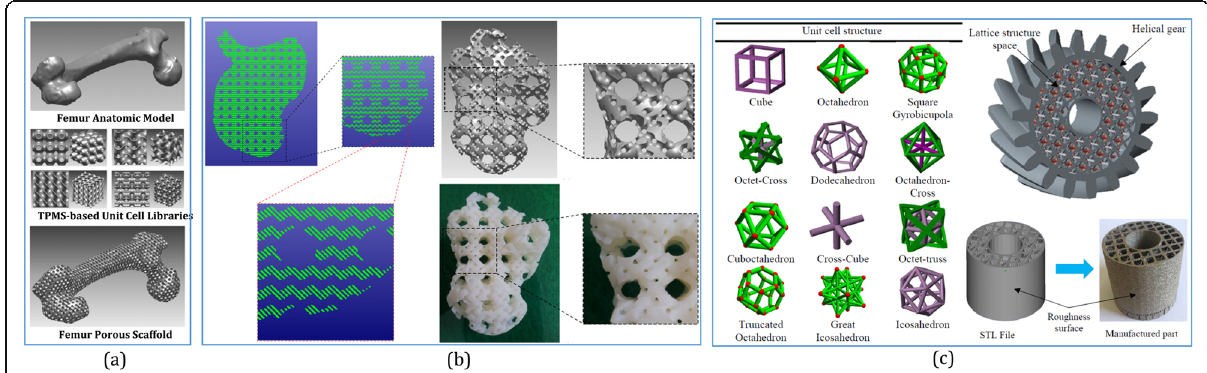
Fig. 10 a Utilizing TPMS-based unit cell libraries to generate porous scaffolds from the subdivided hexahedral elements [89]. b The generated TPMS scaffolds could be intersected with TPMS libraries again by the distance field to generate hierarchical TPMS scaffolds [90]. c For any complex models, diverse unit cells can be selected or even combined to design the ideal lattice structures